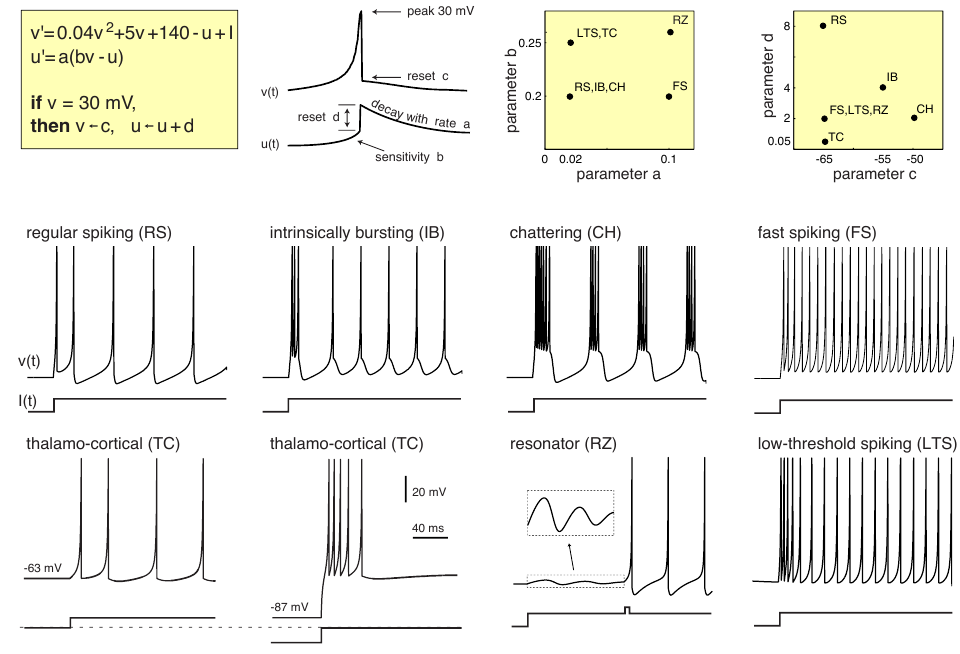
Figure 1. Spiking and bursting behaviour of known types of cortical neurons [5]. (The electronic version of the figure and reproduction permissions are freely available at